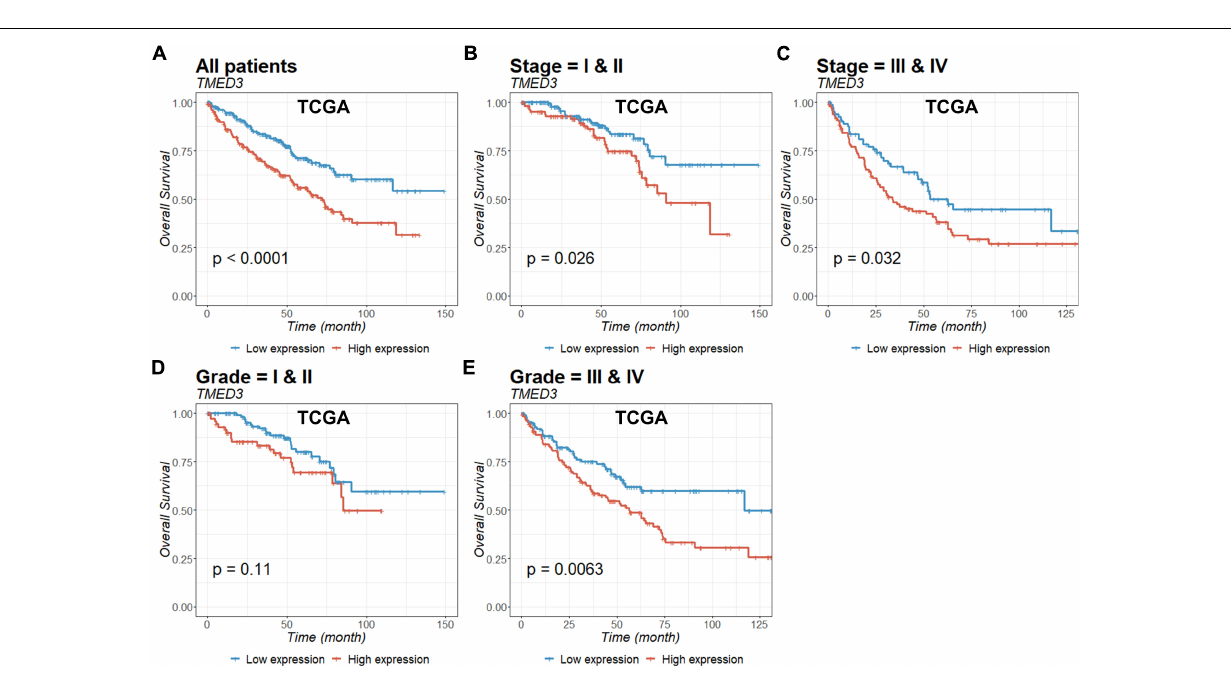
FIGURE 2 | Kaplan-Meier survival curves of ccRCC patients according to TMED3 expression levels. Overall survival of all (A) , stage I and II (B) , stage III and IV (C) , grade I and II (D) , and grade III and IV (E) patients in the TCGA cohort.